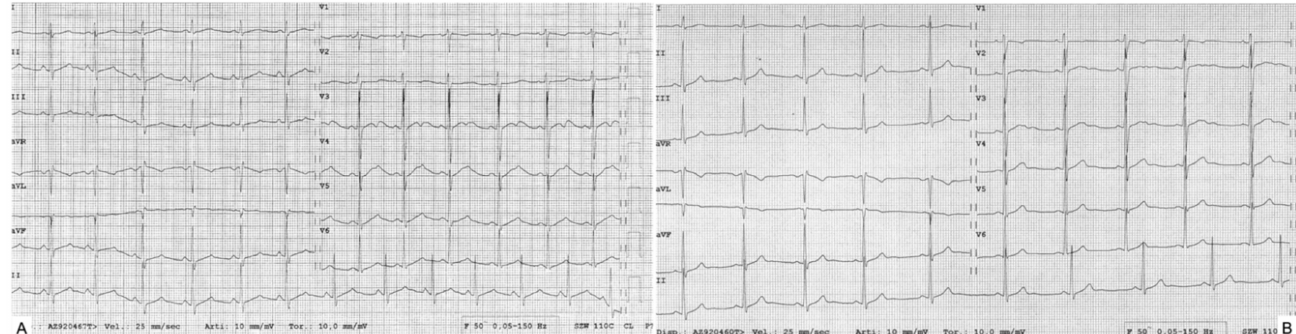
Figure 3. A case of sport-induced long-QT syndrome. Male, 15-year-old, plays water polo at a com- petitive level (training >10 h/week). Negative medical and family history. ECG at pre-participation screening: QTc 597 ms, HR 79 bpm ( A ), with notched morphology of T waves. Detraining was recom- mended. Genetic testing of the genes associated with LQTS resulted negative. ECG after 3 months of detraining: QTC 394 ms, HR 58 bpm ( B